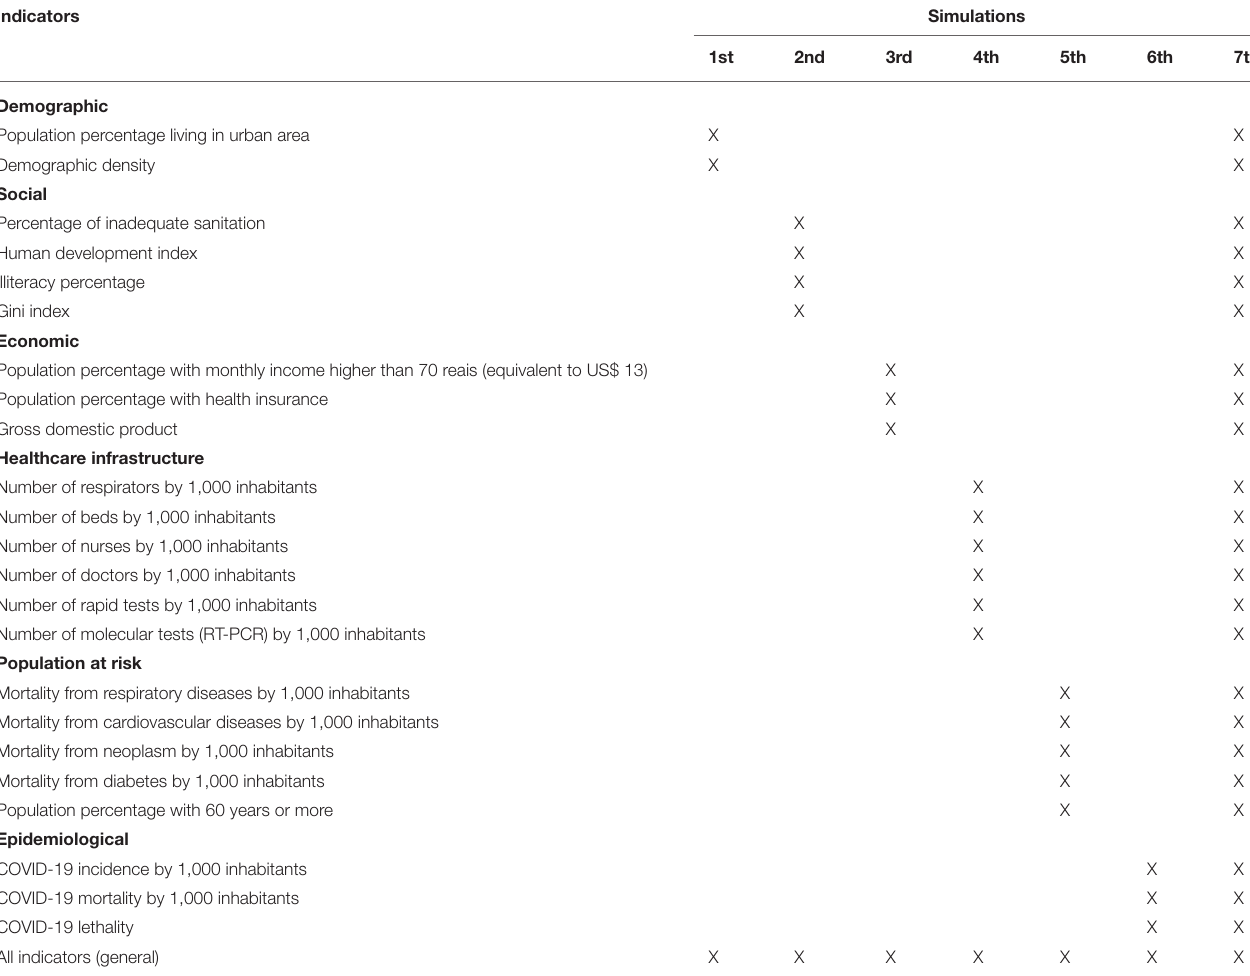
TABLE 2 | Simulations performed by category of indicators (1–6) and the general simulation (7), gathering all the indicators simultaneously.